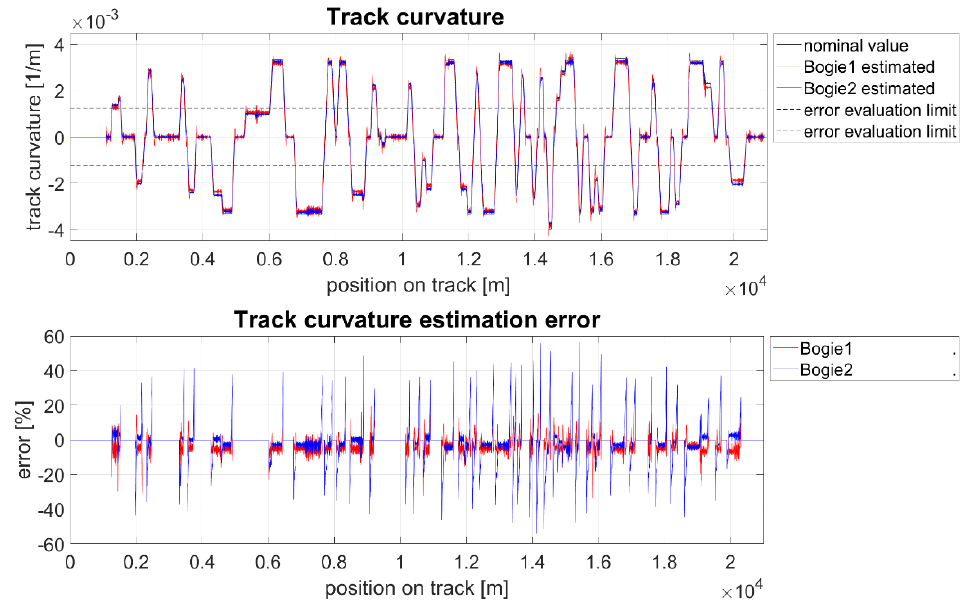
Figure 13. Simulation of the track Letohrad–Lichkov run for the friction coefficient f = 0.15. Comparison of the nominal value of the track curvature and the track curvature estimated by bogie to car body angle measurement.